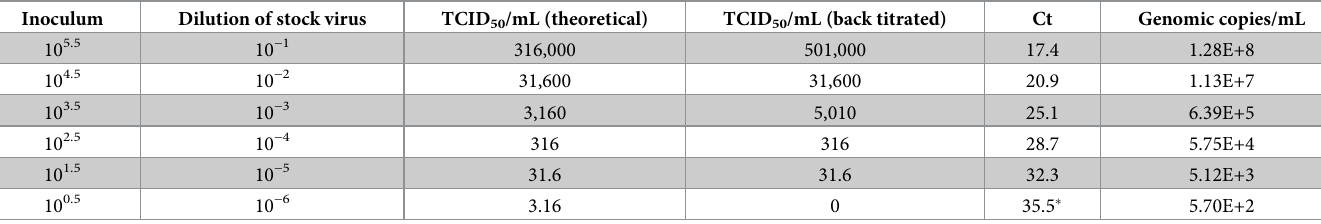
Table 3. Titers, PCR Ct values, and genomic copies/mL of virus dilutions used to inoculate neonatal pigs. Inoculum